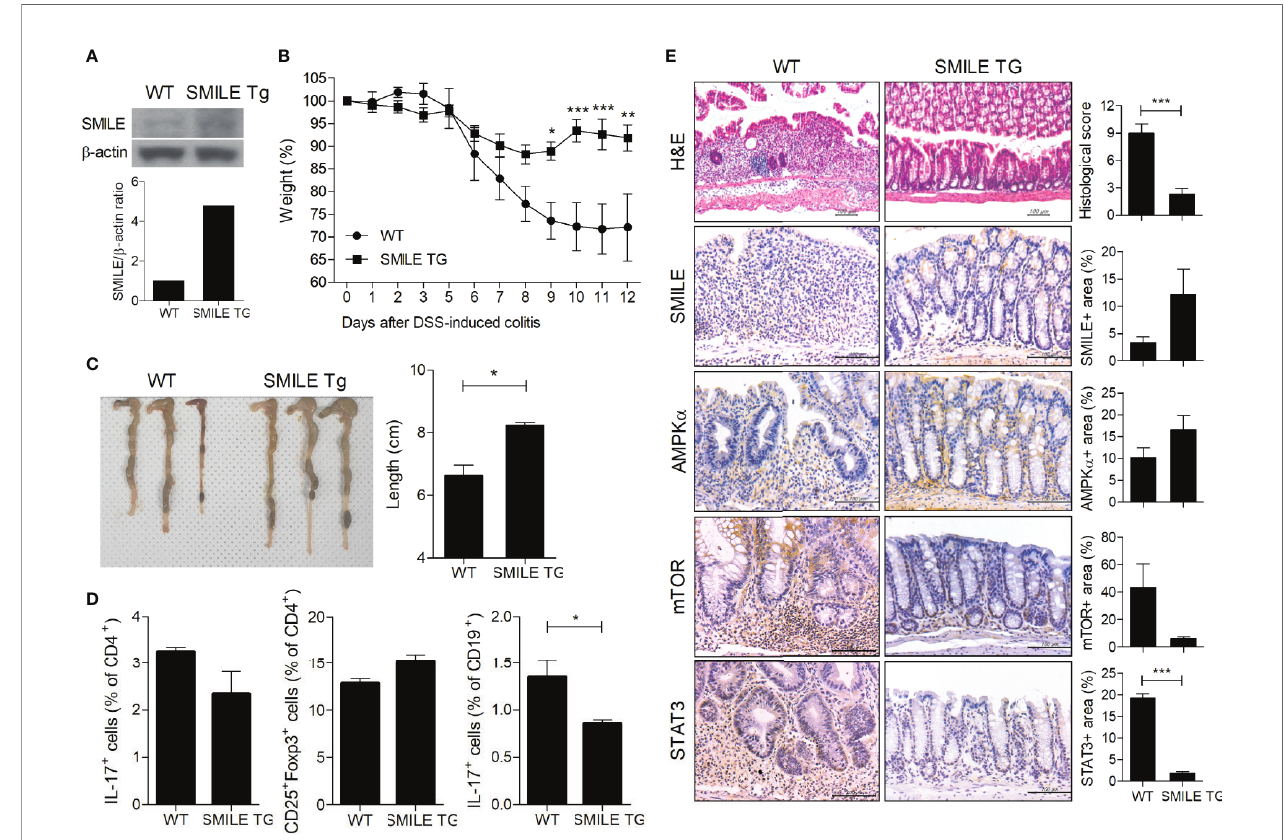
FIGURE 4 | Therapeutic effect of SMILE in transgenic mice. (A) Transgenic mice overexpressing SMILE were generated on a C57BL/6 background. (B) WT and SMILE TG mice were treated with DSS and body weight was measured as a percentage of that at baseline (n = 5 per group). (C) Representative macroscopic images and colon length of WT and SMILE TG mice. (D) MLN cells analyzed by fl ow cytometry. (E) Colon tissue of WT and SMILE TG mice was subjected to H&E and IHC with anti-SMILE, -mTOR, -AMPK, and -STAT3 antibodies. Data are means±SEM of two replicates. * P < 0.05, ** P < 0.01, *** P <